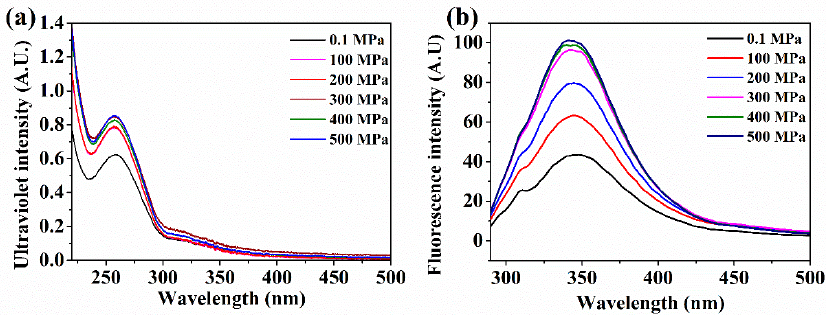
Figure 3. The UV scanning spectrum ( a ) and intrinsic fluorescence spectra ( b ) of control and HP treated oyster proteins.